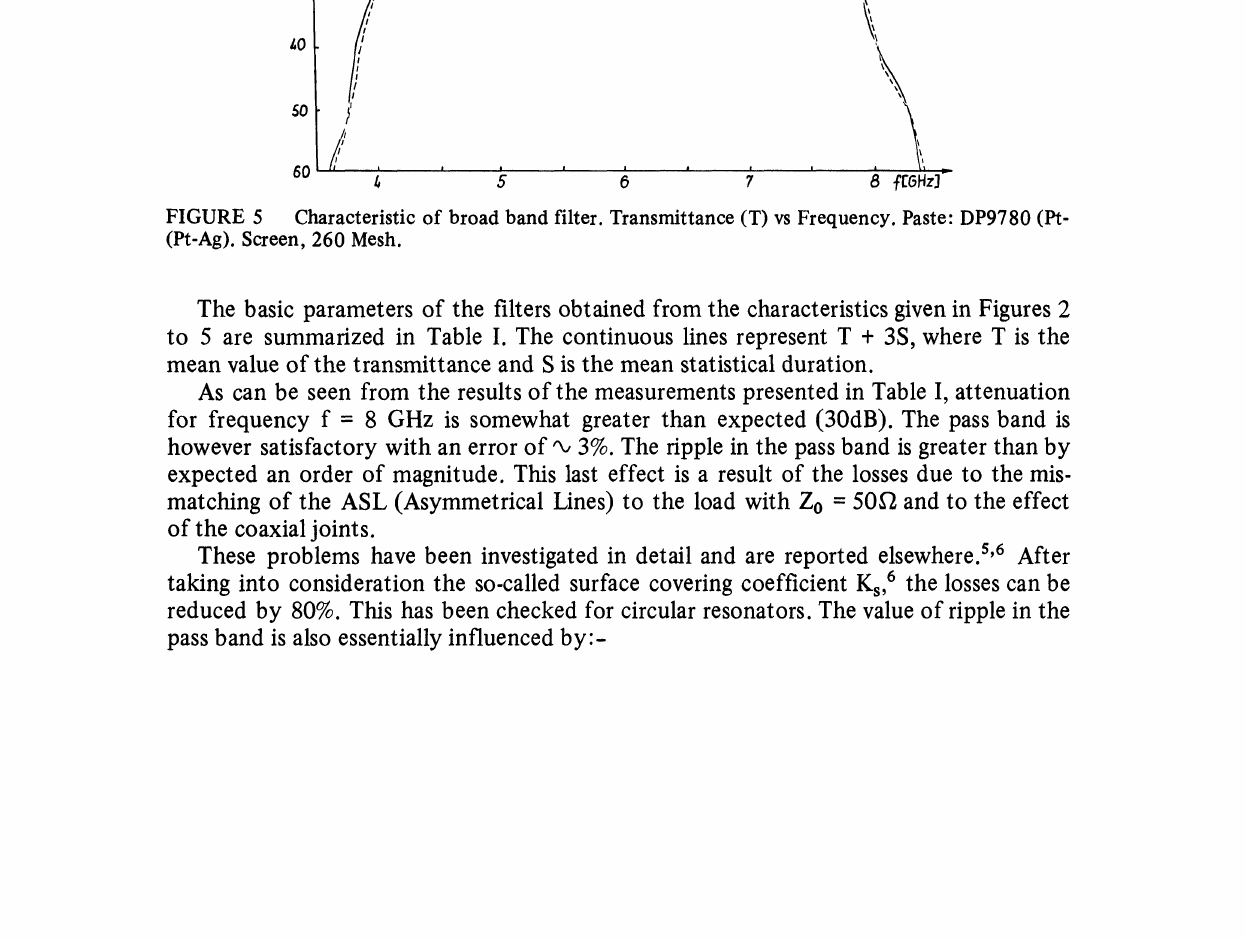
FIGURE 4 Characteristic of broad band filter Transmittance (T) vs Frequency Paste: DP9780 (Pt-Ag). Screen, 330 Mesh.